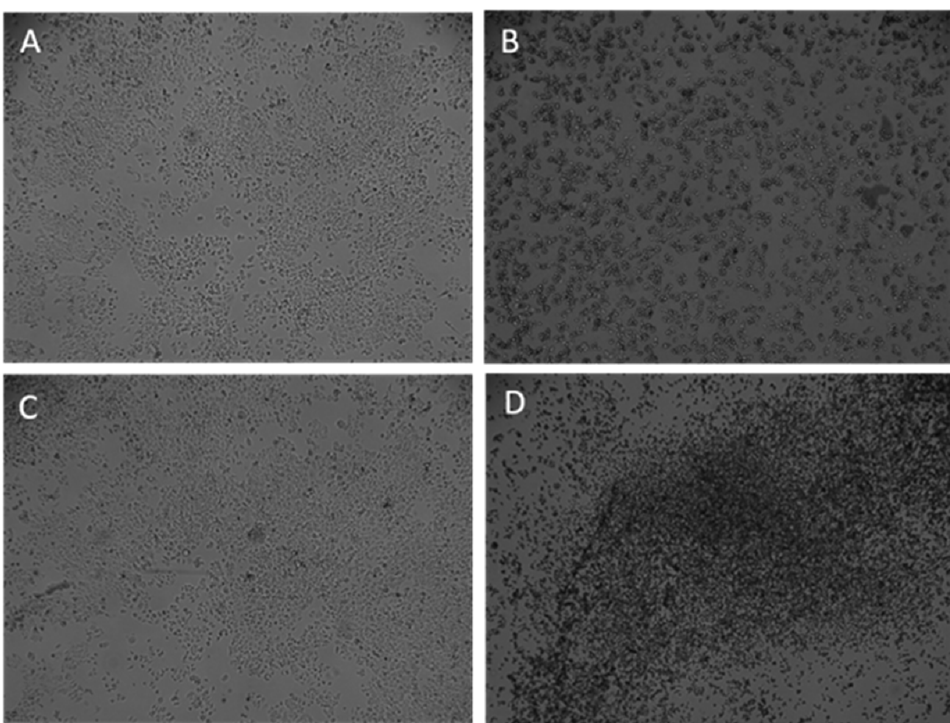
Figure 2. Imaging by LionHeart equipment of MCF-7 cells. ( A ) Control MCF-7 cells at 24 h, ( B ) MCF-7 cells treated with paclitaxel at 50 nM with no visible clustering, ( C ) Control MCF-7 cells after 24 h for benztropine, ( D ) MCF-7 cells treated with 100 µ M benztropine, showing the formation of clusters.